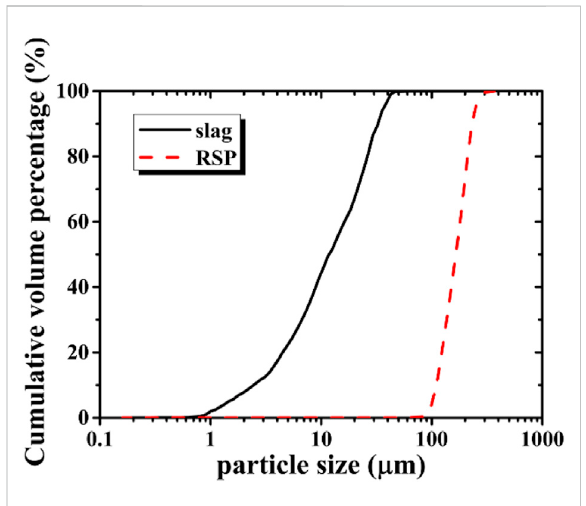
FIGURE 2 The particle size distributions of slag and rice straw